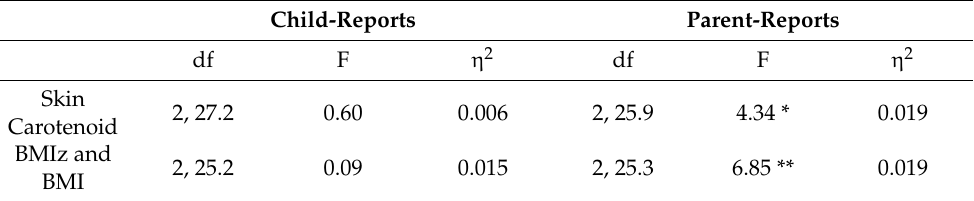
Table 3. Results of Repeated Measures ANOVA for Child and Parent Skin Carotenoid and